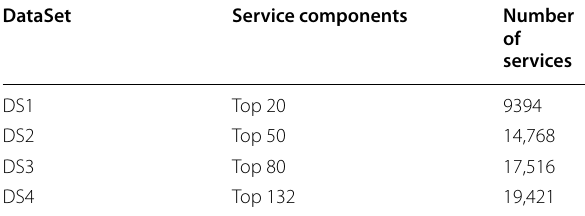
Table 1 Outline of datasets DataSet Service components